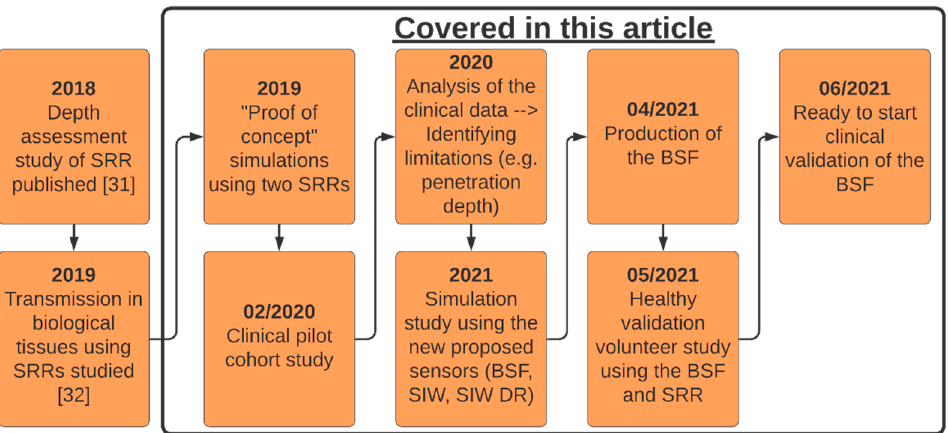
Figure 1. Illustrative timeline of previous works and the progress for the MAS device, BSF = Bandstop filter, SRR = Split-ring resonator, SIW = Substrate Integrated Waveguides sensor, SIW DR = SIW with dielectric resonator sensor.